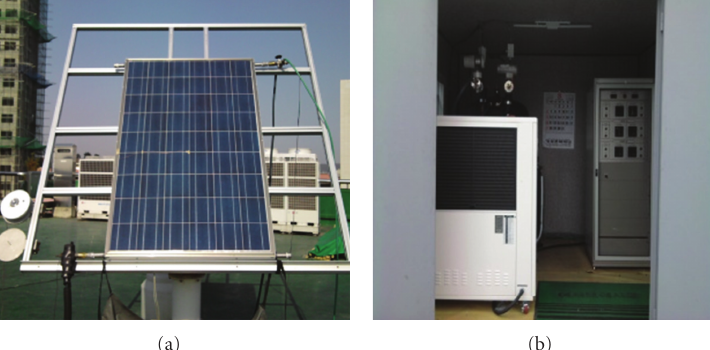
00.10.20.30.40.50.6